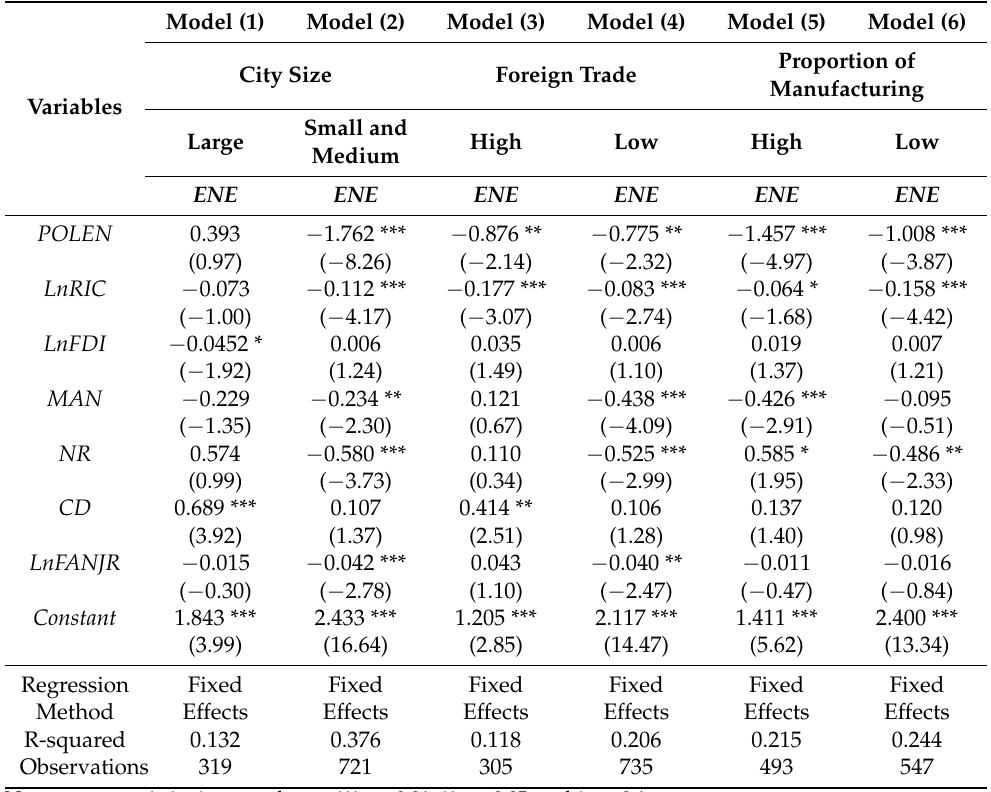
Table 6. Heterogeneity test results B: heterogeneity of city